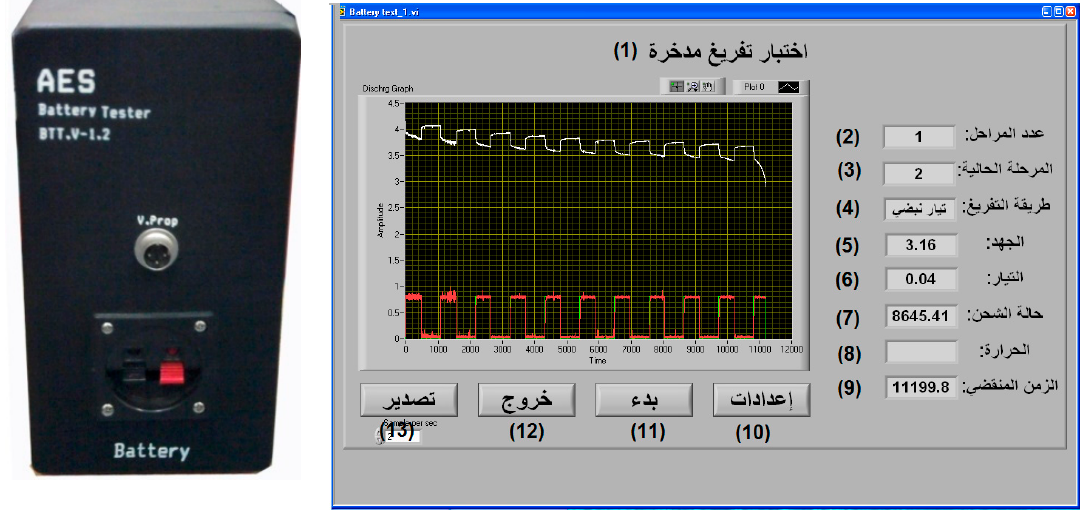
Figure 2. Experimental device and user interface (1) battery discharge test (2) step number (3) current